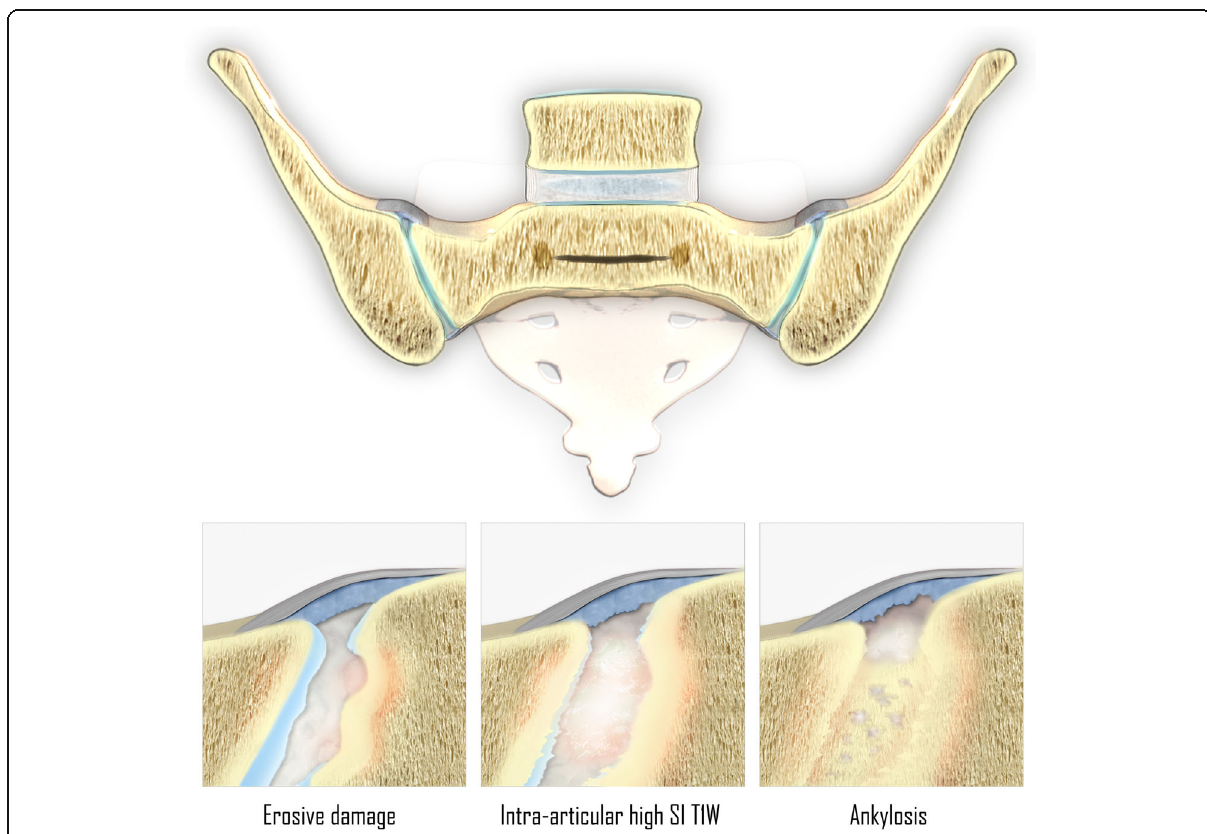
Fig. 1 Features associated with new bone formation in the sacroiliac joints of patients with SpA. Note: erosive damage occurs before new bone formation. (SI T1W = signal intensity on T1-weighted MR